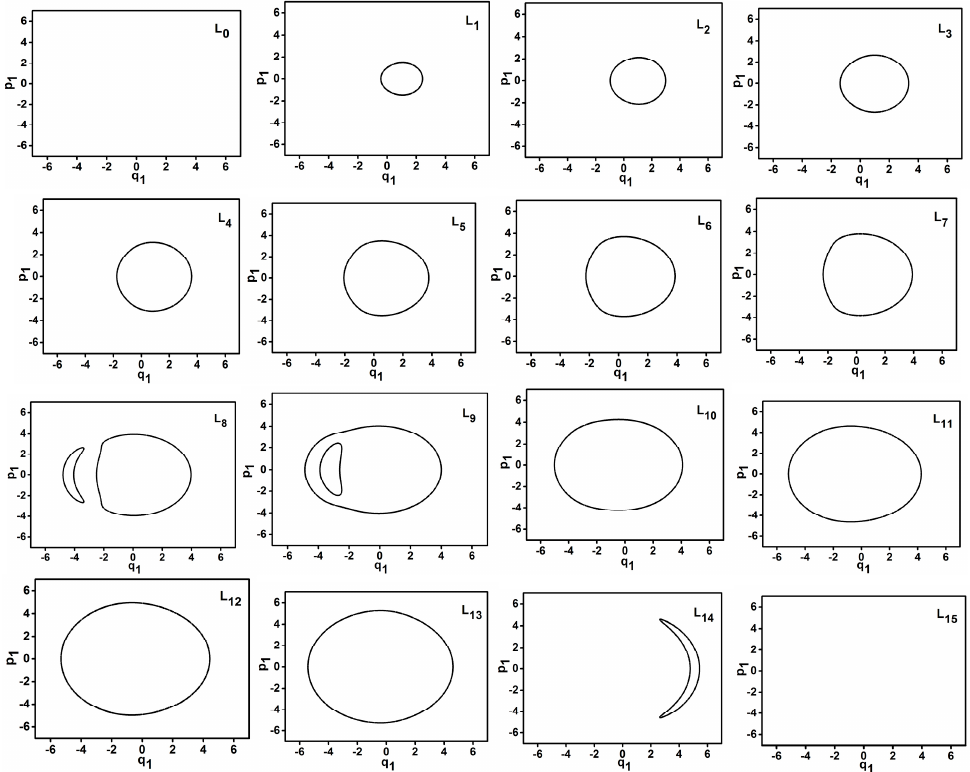
Figure 4. Trajectories of phase space of L0–L15 when P = 30 ( 1 q coordinate).